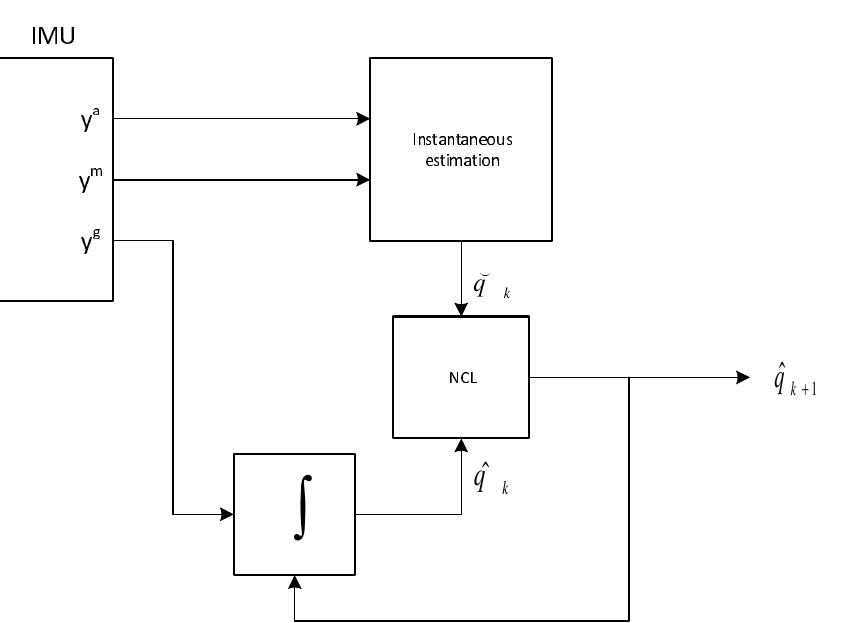
Figure 5. The NCF flow